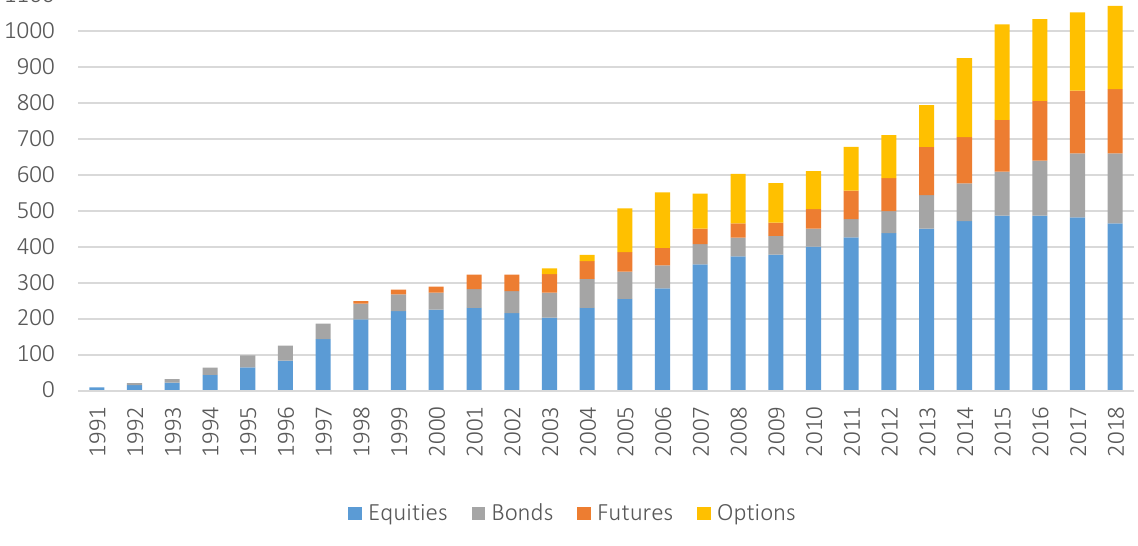
Figure 1. Instruments traded on WSE in